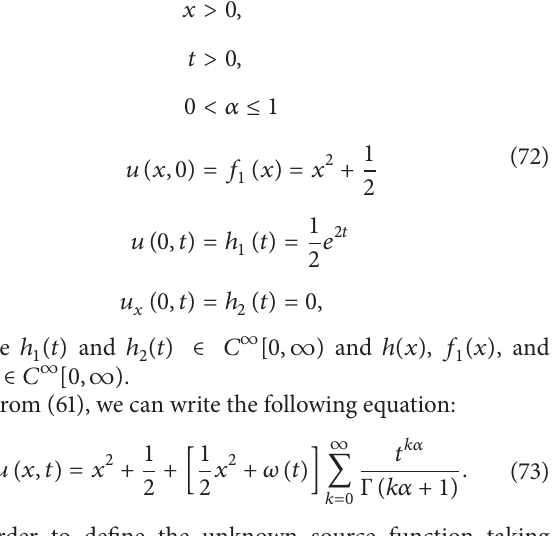
and has appropriate technique to find the analytic solution to inverse problems and many complex problems. Matlab